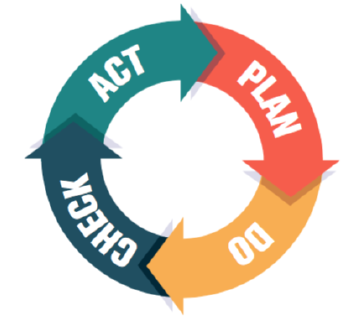
Figure 1: PDCA for systematic